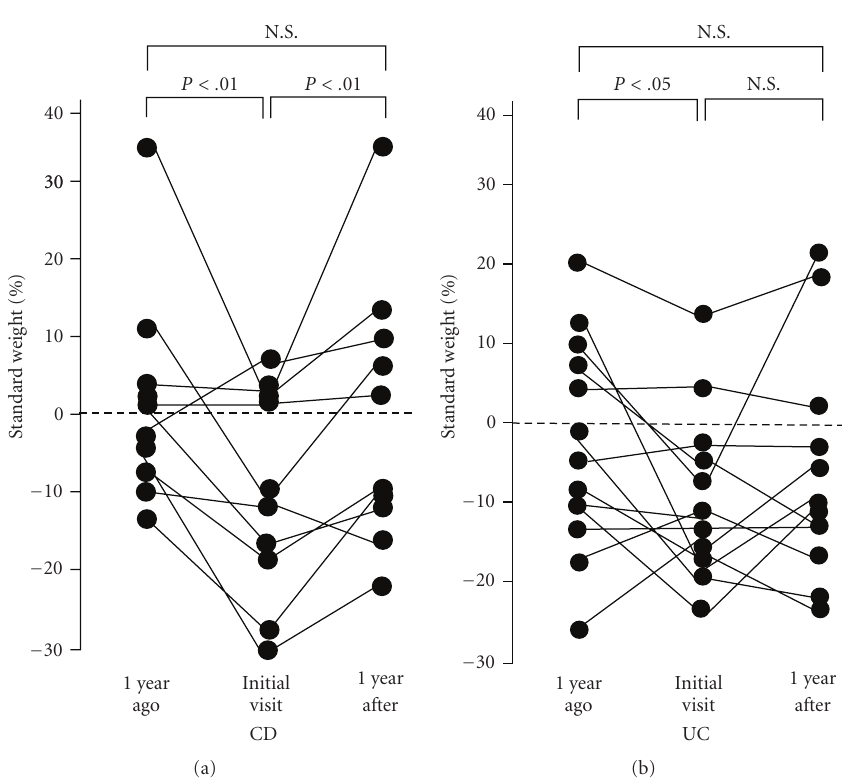
Figure 3: Changes in % standard weight in children with CD and those with